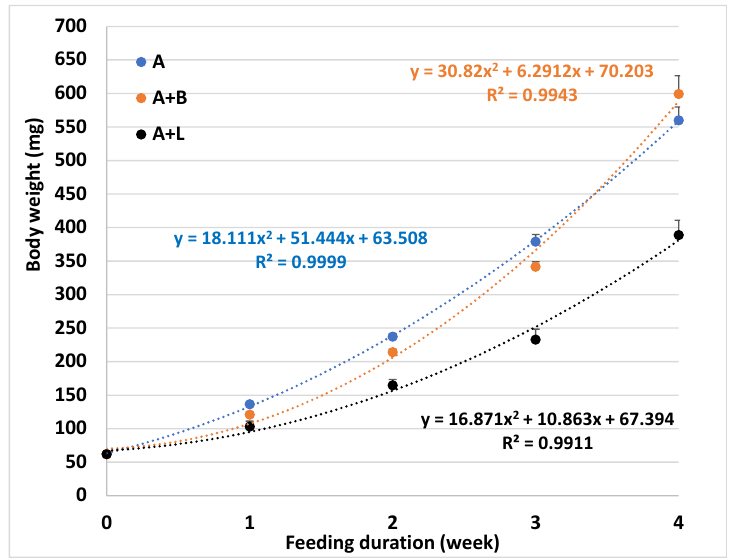
Figure 1. Average body weight (n = 3) of sturgeon fed different test diets during a 4-week feeding (Trial-I). A, Artemia ; A + B, combined feeding of Artemia and commercial diet. A + L, combined feeding of Artemia and lab diet.